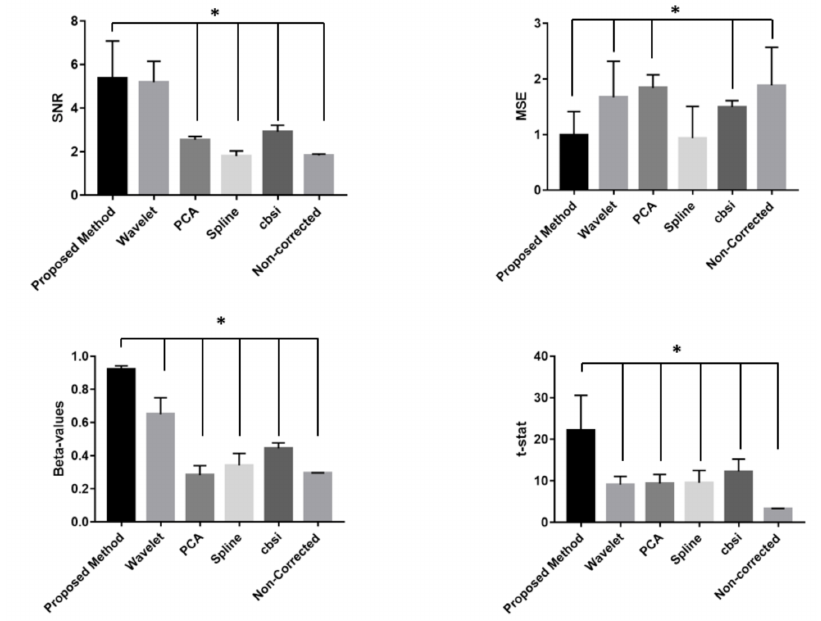
Figure 8. Average and standard deviation of the metrics employed to compare the motion artifacts correction. Statistically significant comparisons of paired t -tests are marked with an